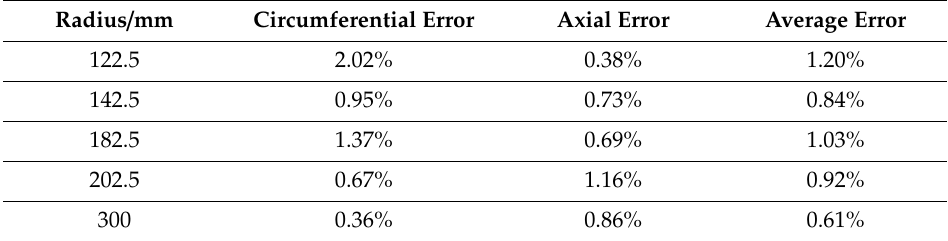
Figure 14. Damage localization results of curved plates with different radius. Table 4. Localization errors of curved plates with different radius.